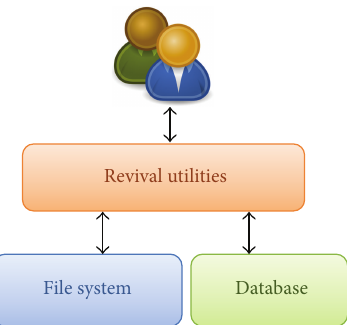
Figure 7: Logical scheme of the user-software system at the Fondazione Arena.